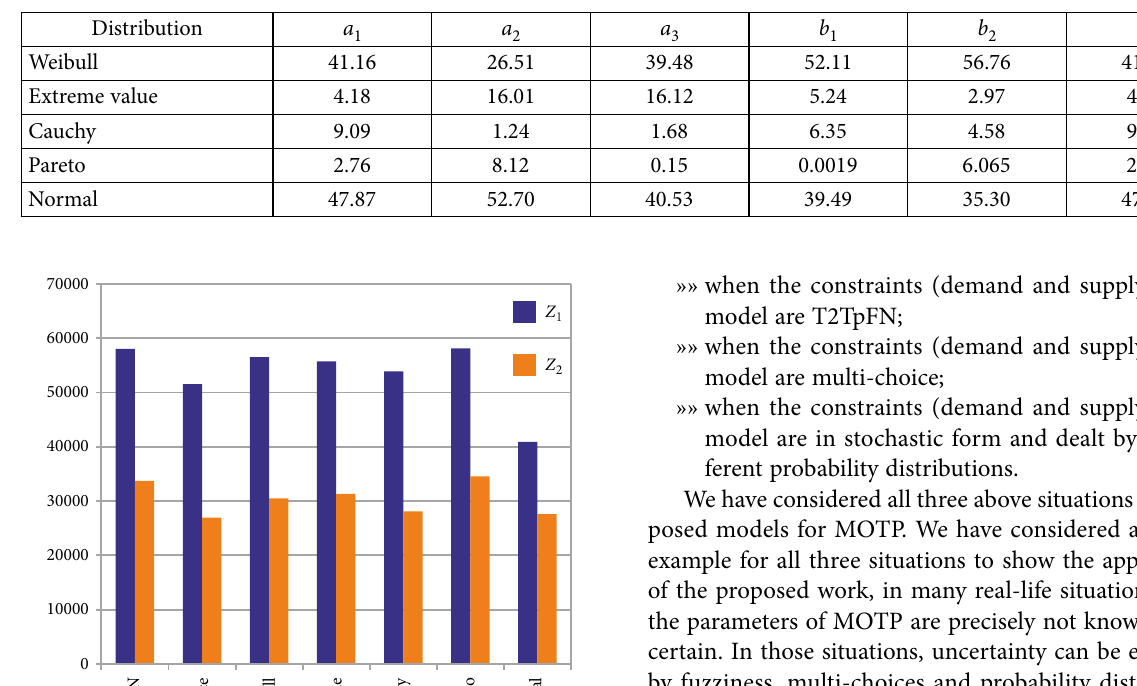
Table 14. Akaike weights [%]